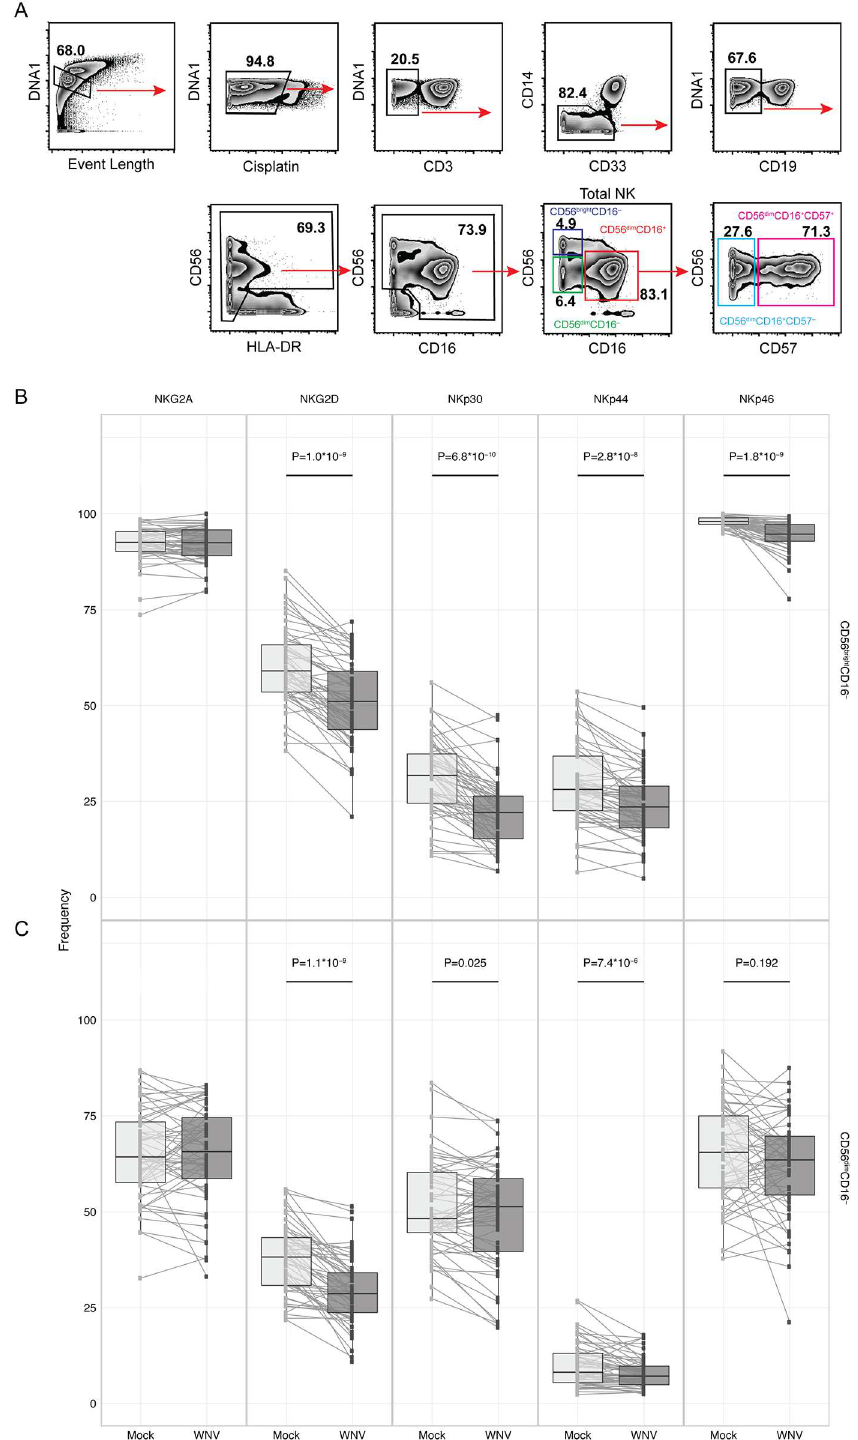
Fig 2. Downregulation of activating receptors in NK cells in response to WNV infection. PBMCs were incubatedwith medium alone (mock) or infected with WNV (MOI = 1) for 24 h. The samples were labeledwith metal-conjugatedantibodies and analyzedby mass cytometry. (A) Manualgating strategy to define NK cell subsets. CD56 bright CD16 - (B) and CD56 dim CD16 - (C) NK cell subsets were compared betweenmock and WNV-infected groups for expressionof NK cell inhibitoryreceptor NKG2A and activatingreceptors NKG2D, NKp30, NKp44, and NKp46 (n = 56). Paired Wilcoxon